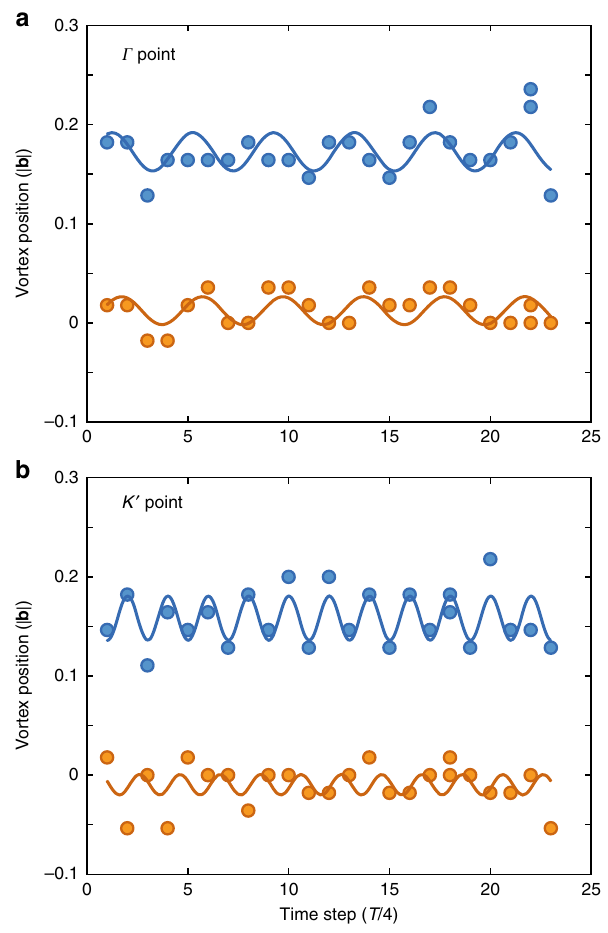
Fig. 10 Micromotion of the static Dirac points. Position of the static vortices for the observed time steps (multiples of 39 μ s, driving period T is four time steps). a Static vortex at the Γ point. b Static vortex at one of the K ′ points. The k x position is shifted by + 0.2| b | in a and + 0.7| b | in b for better visibility. The motion is approximately circular with the k x direction (blue points) being out of phase with the k y direction (orange points). The vortex at the Γ point moves dominantly with the driving frequency. The vortex at the K point moves dominantly at twice the driving frequency. The lines show fi ts as a guide to the eye with the periods fi xed at T and T /2, respectively. Both amplitudes are very small (few percent of the lattice vector length | b |). The positions are determined to the precision of a single pixel of the images, which corresponds to 0.018| b |. The detuning is δ /2 π = − 478